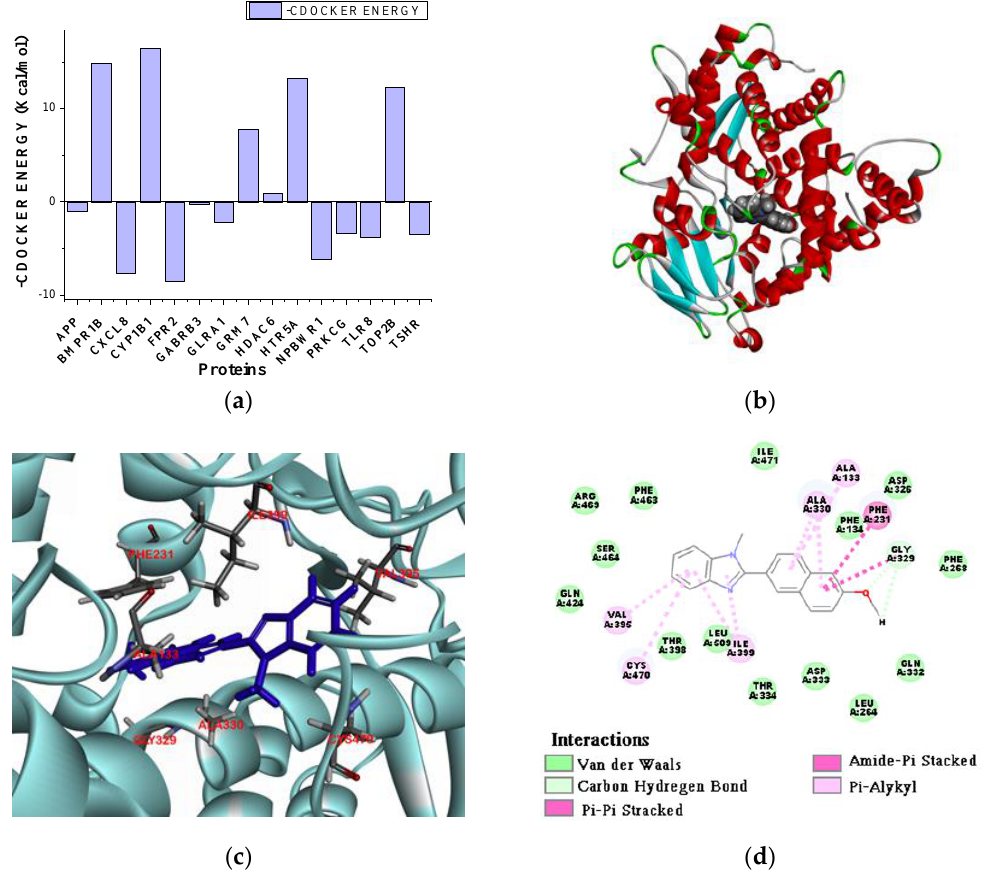
Figure 2. Molecular docking simulations. ( a ) CDOCKER ENERGY of potential targets; ( b ) Molecular docking of compound 3g into CYP1B1 protein; ( c ) Three-dimensional representation of the complex (CYP1B1 protein and 3g compound); ( d ) Two-dimensional interactions diagram of the